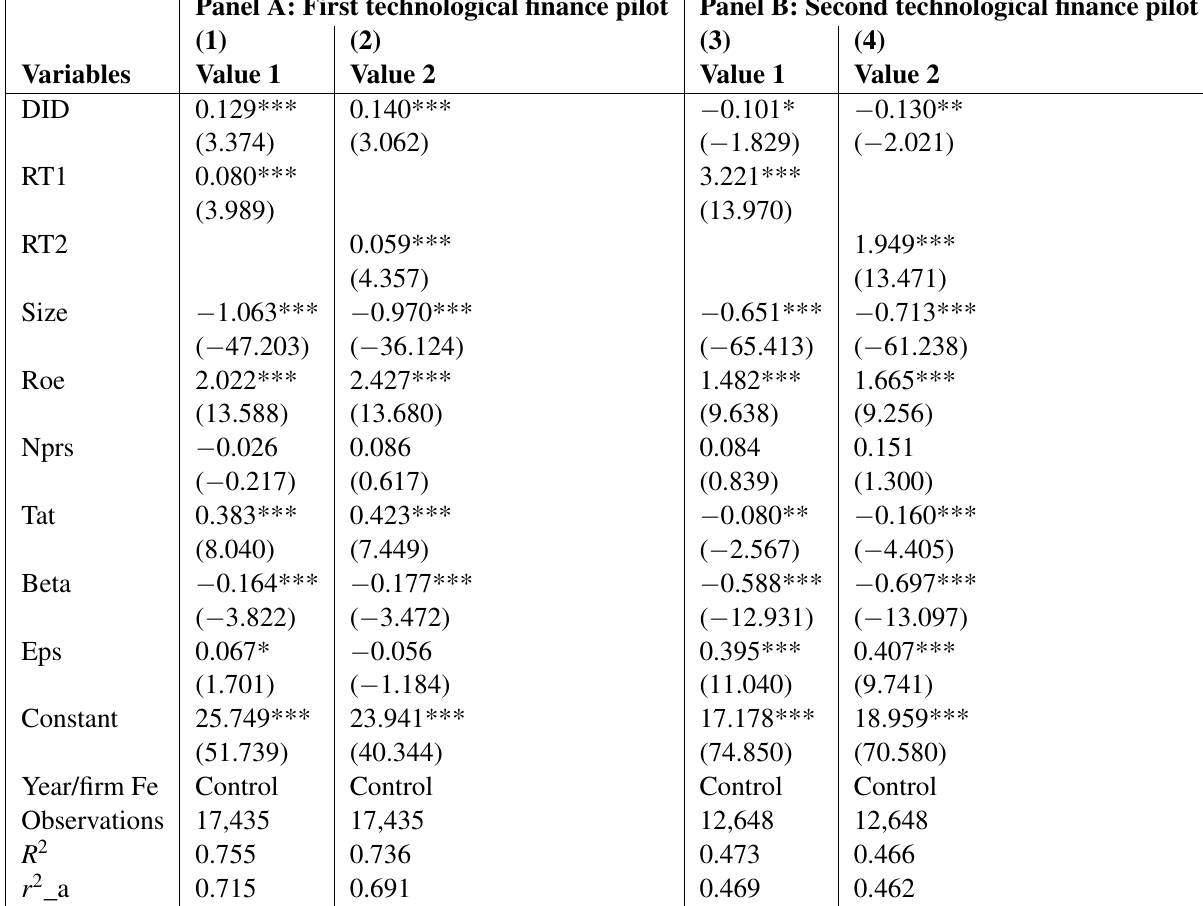
Table 3 Regression results of the relationship between technological finance pilots, risk-taking and corporate value Panel A: First technological finance